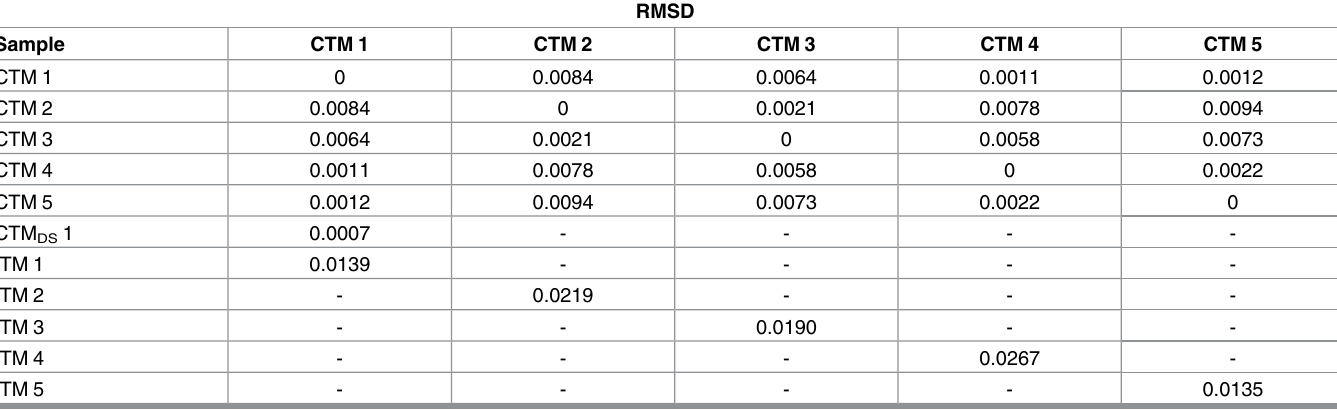
Table 3. RMSD, for five samples from the ITM and the corresponding samples from the ITM. A down-sampled version of CTM sample 1 (CTM DS 1) is also